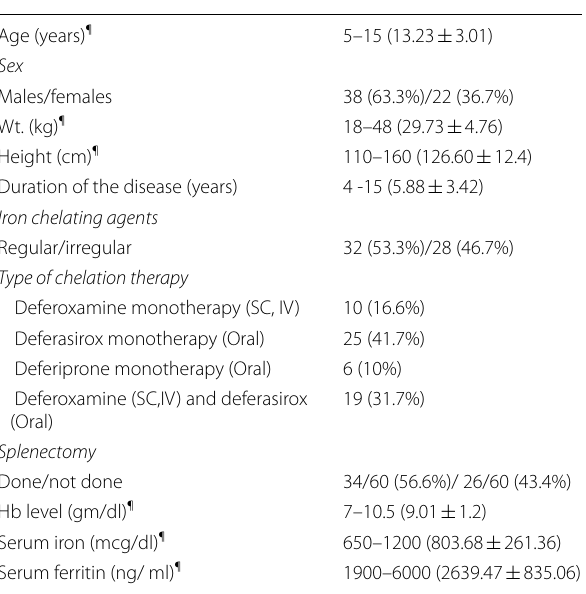
Table 1 Clinical characteristics and laboratory data of 60 children with transfusion-dependent beta-thalassemia major